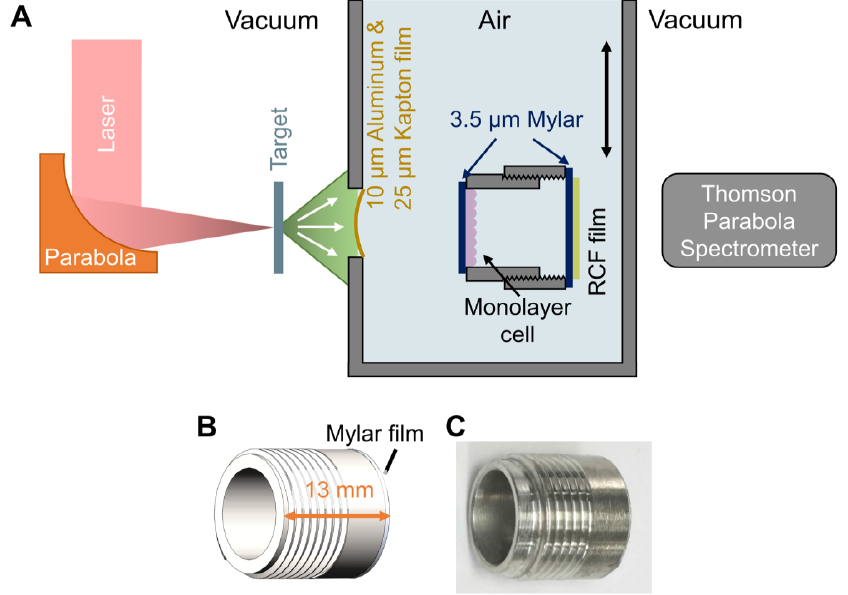
Figure 9. Experimental setup for FLASH irradiation. ( A ) Schematic drawing of the experimental setup. ( B , C ) Side view of the cell-culture cylinder. The cells were cultured on the 3.5 µm Mylar film adhered to inner side of the cylinder.